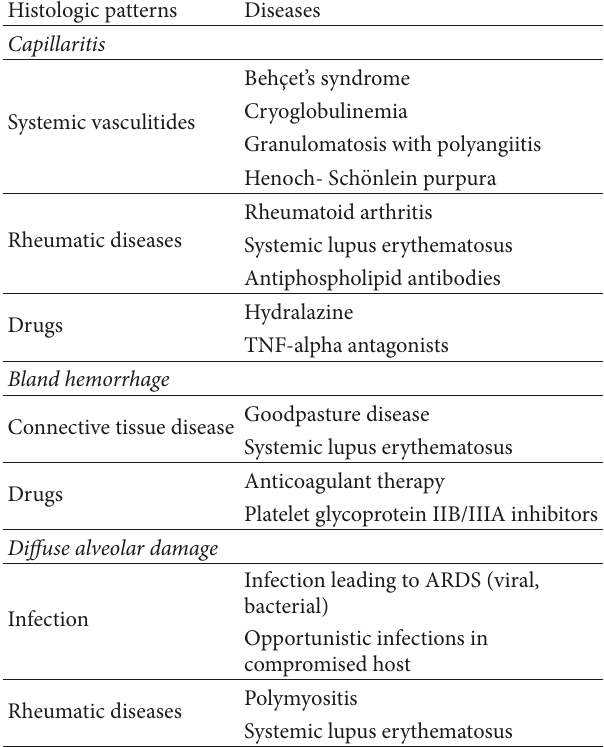
Table 1: Selected differential diagnoses of the three histologic patterns of diffuse alveolar hemorrhage (after Park